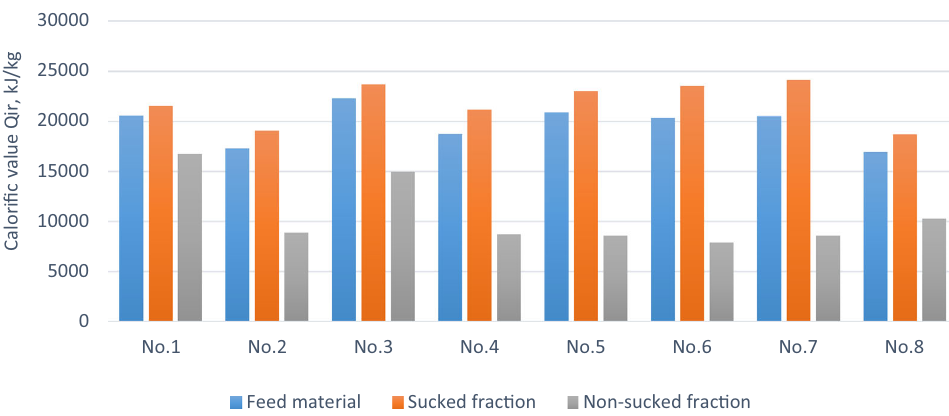
Fig. 13 Calorific value with respect to the origin of the feed material (grain-size class of 0–20